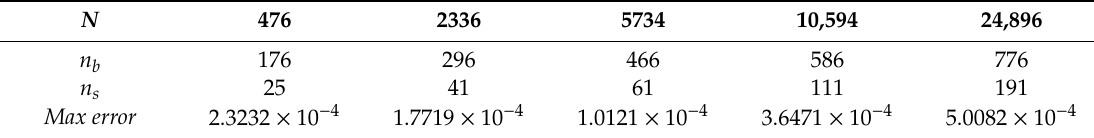
Table 4. Maximum absolute error for test 1 in case 4.